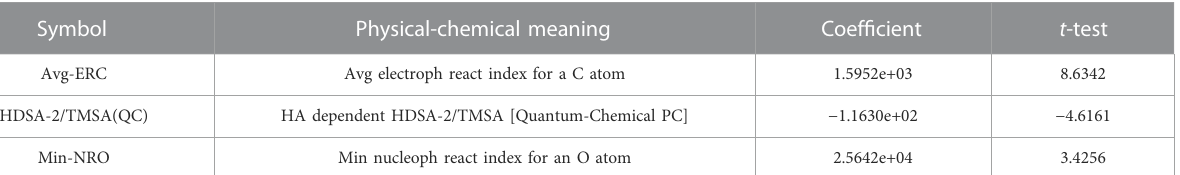
TABLE 2 Details of the three selected descriptors.